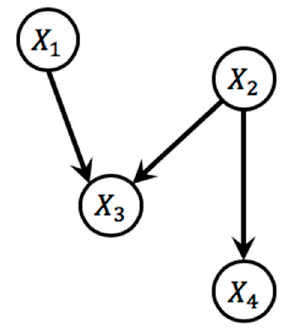
Figure 1. An example of a Bayesian network.